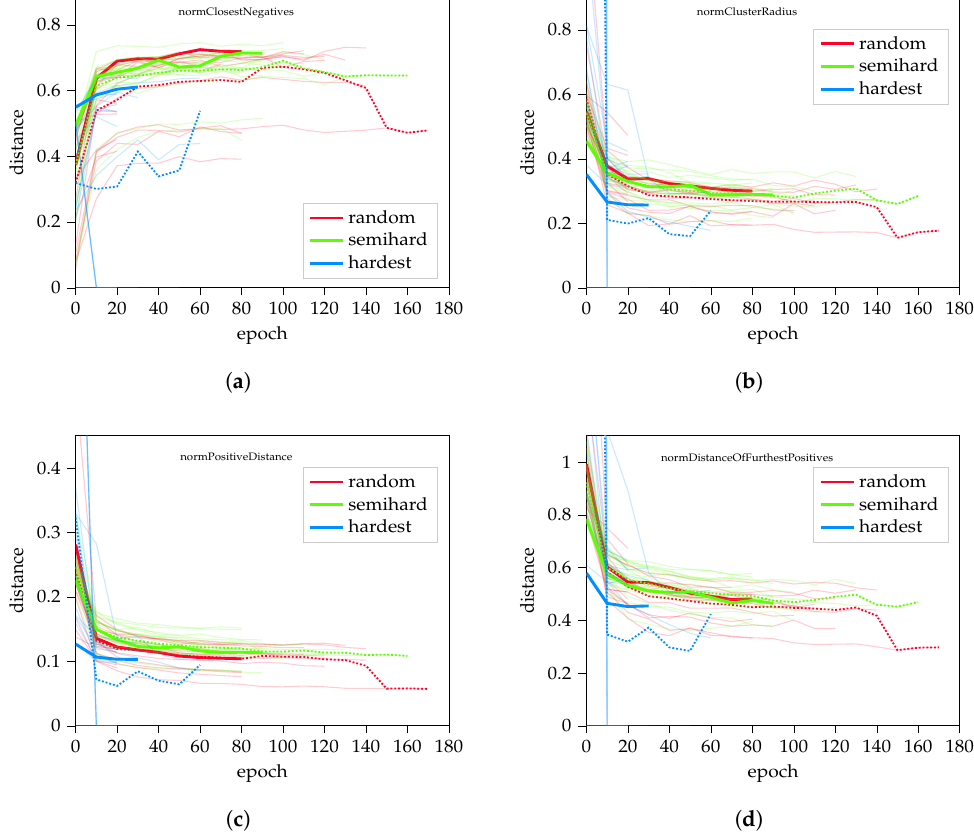
Figure A2. Values normalized by the average distance of elements for random hard, semi-hard and hardest negative mining. Subfigures show ( a ) the normalized dynamic of closest negative distance, ( b ) cluster radius length, ( c ) the distance between positive pairs and ( d ) the distance of furthest positives, respectively.